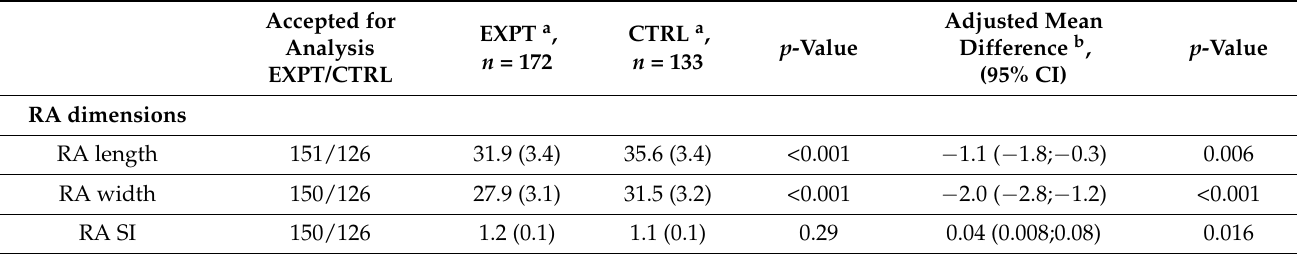
Table 2. Right heart dimensions and volumes in 6.5-year-old children born extremely preterm (EXPT) and in controls born at term